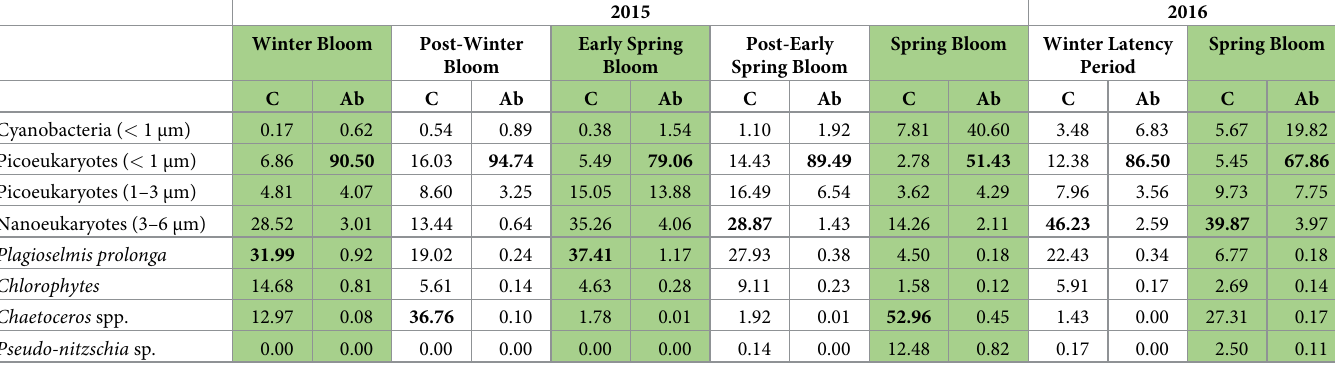
Table 3. Relative contributions of the dominant phytoplankton groups to the carbon biomass and